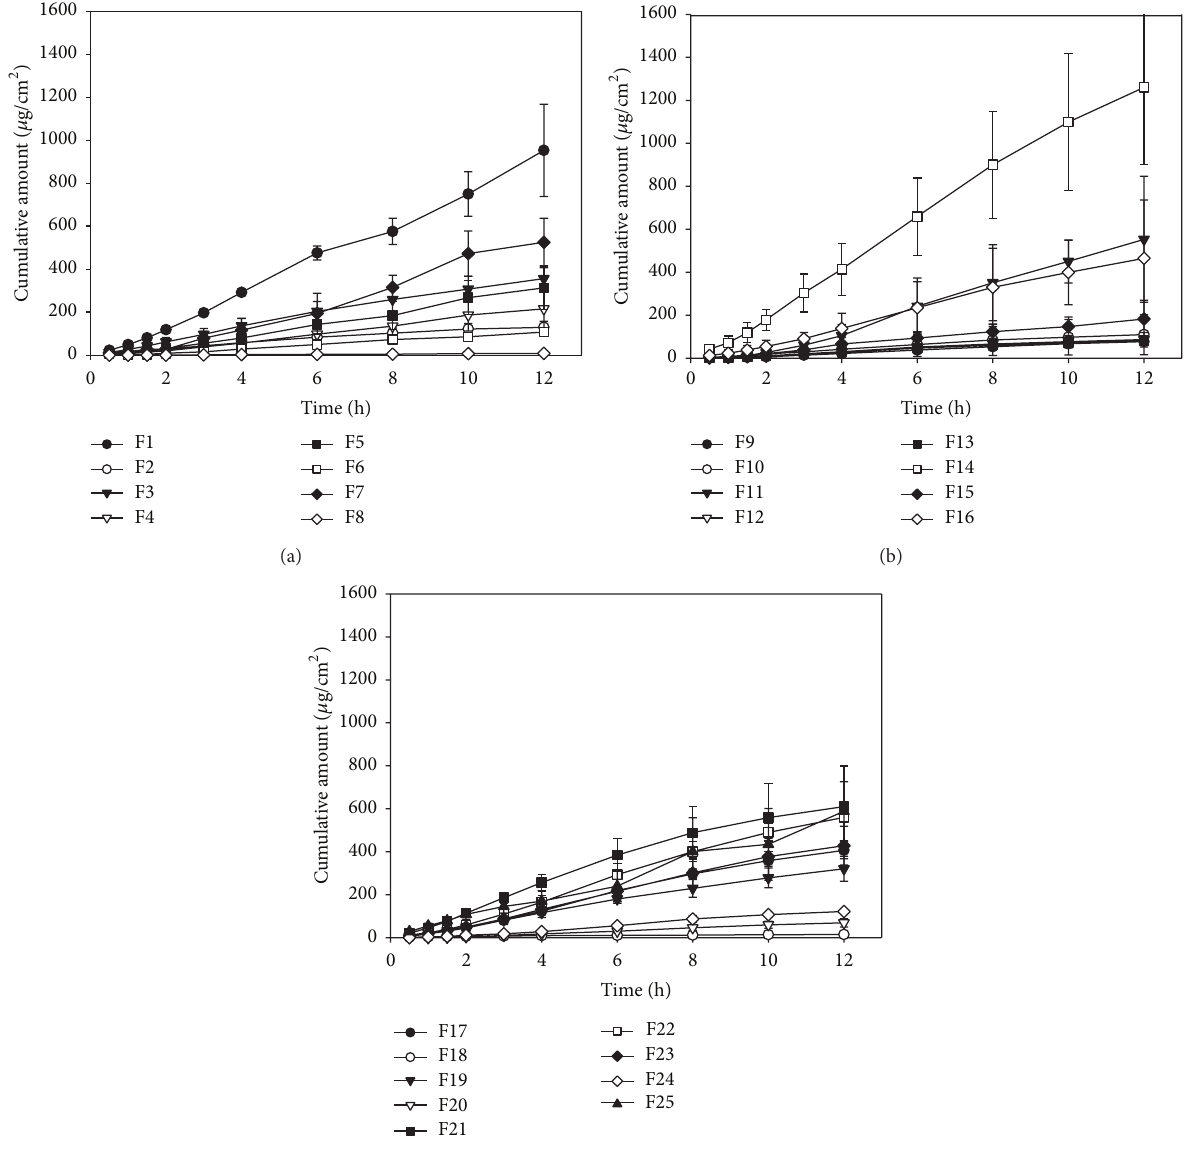
Figure 2: In vitro penetration-time profile of model arecoline-loaded patch formulations through rat skin ( 𝑛 = 3